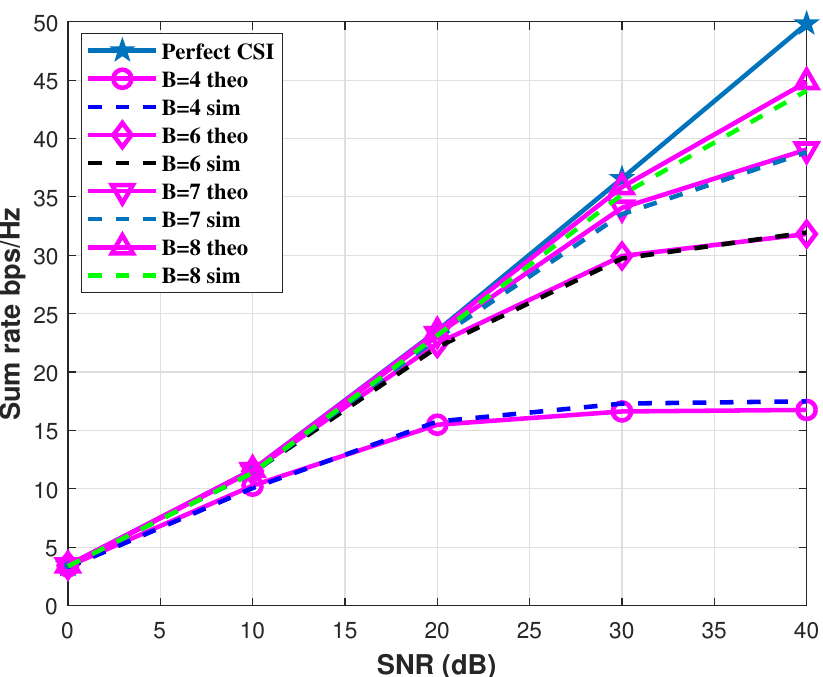
Figure 8. Performance comparison of theoretical and simulation results with SQ-based CSI feedback with different quantization bits in ( 3 × 2,1 ) 4.